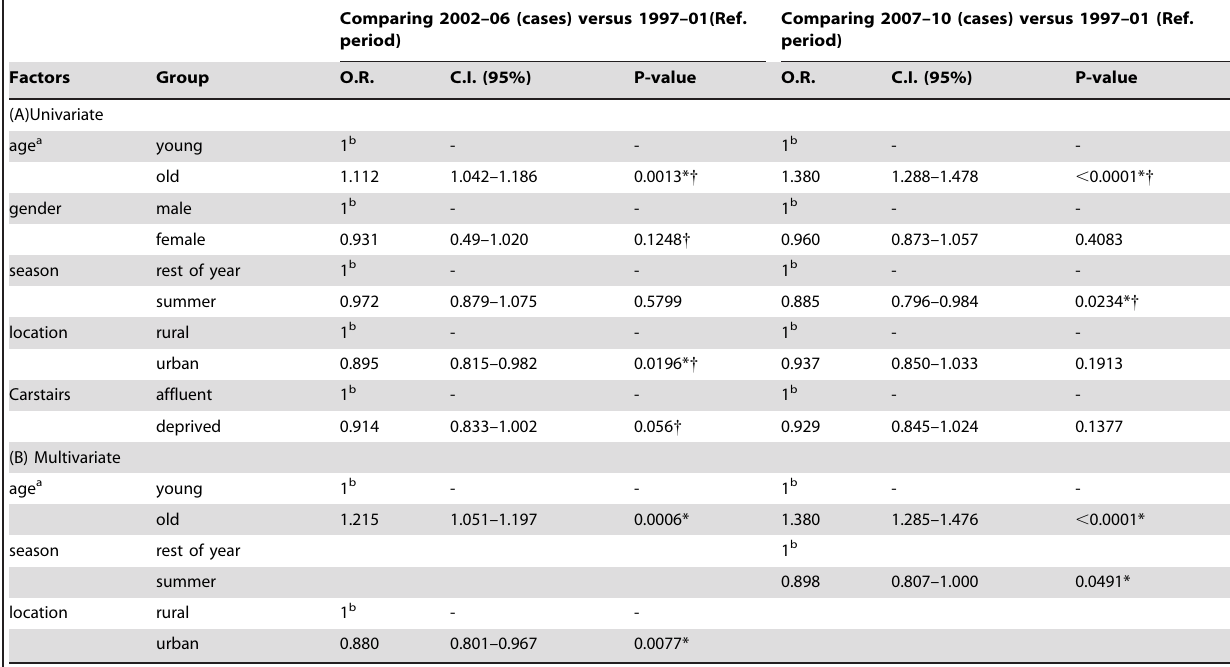
Table 2. Results of the logistic regression for the case-case